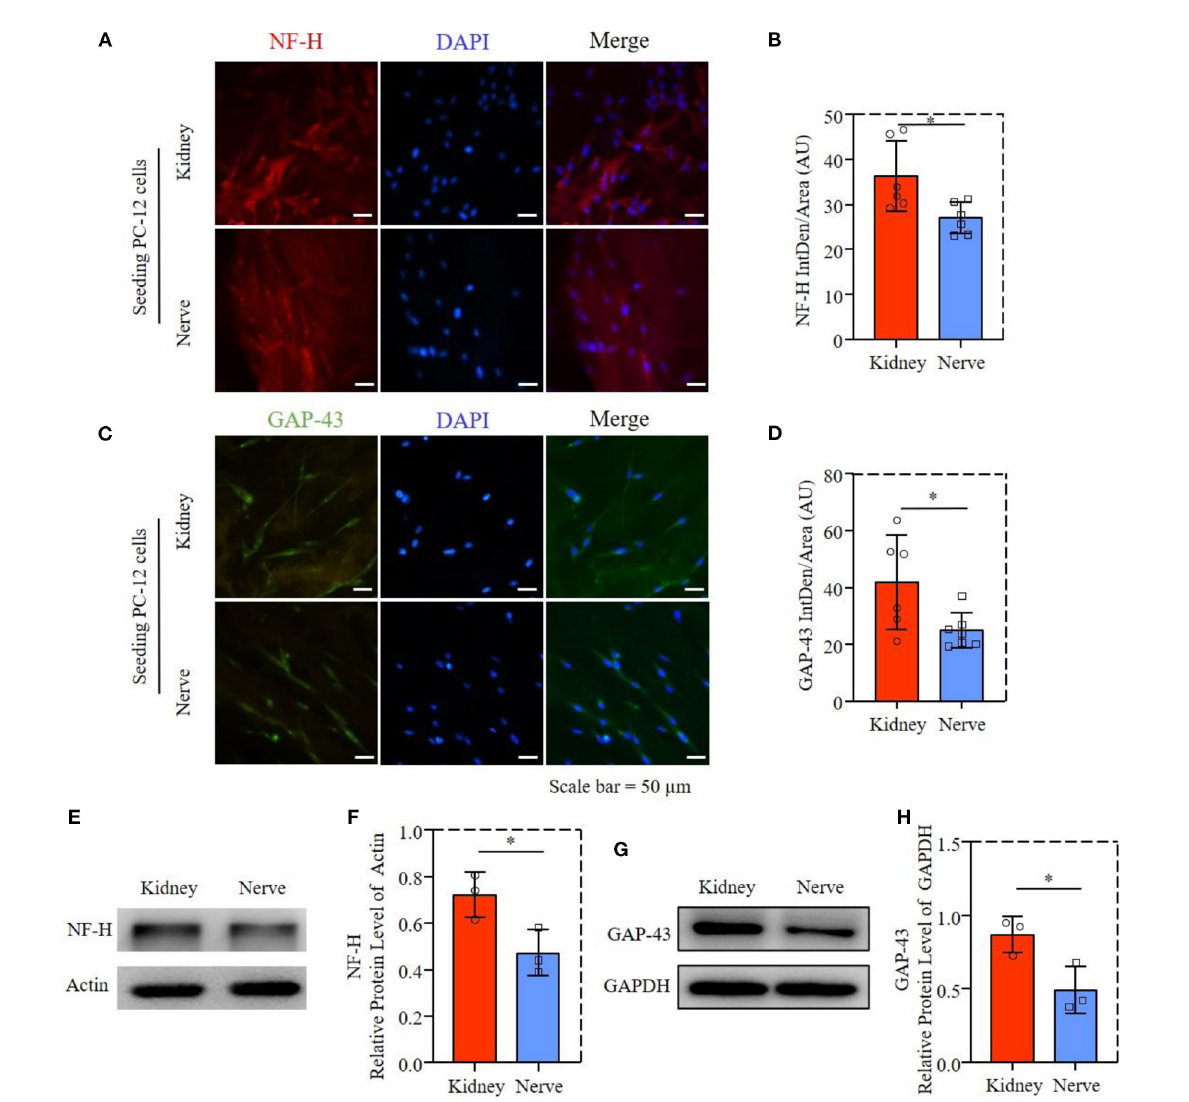
FIGURE6 Axon extension-related proteins expression of PC-12 cells; (A) Fluorescence microscopy images of PC-12 cells stained with NF-H (red) and cell nuclei (blue). (B) Statistical fluorescent intensity of NF-H. (C) Fluorescence microscopy images of PC-12 cells stained with GAP-43 (green) and cell nuclei (blue). (D) Statistical fluorescent area of GAP-43. (E) The NF-H in PC12 cells was determined by western blotting. (F) Relative protein expression of NF-H. (G) The GAP-43 in PC12 cell was determined by western blotting. (H) Relative protein expression of GAP-43. * P ≤ 0.05.